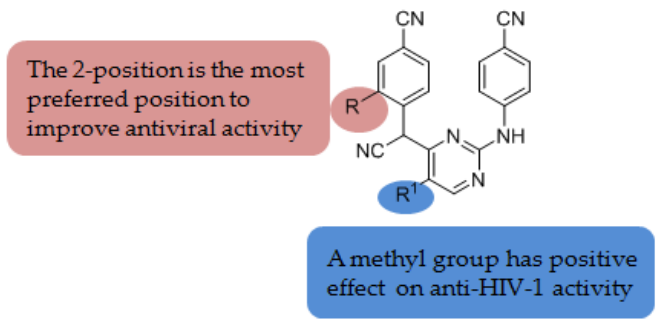
Figure 6. A systematic summary of the structure–activity relationship (SAR).